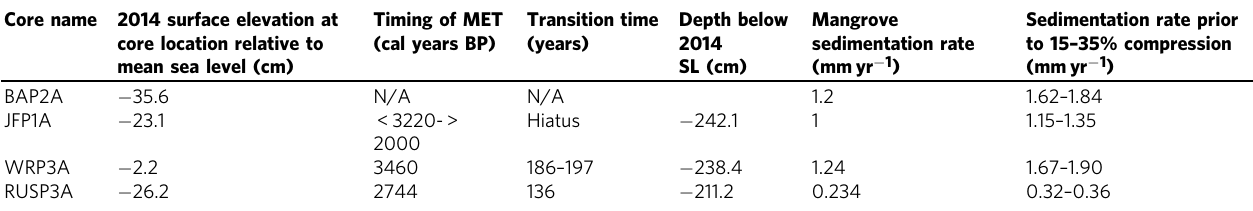
Surface elevations were measured using dGPS and measuring depth from bedrock on each island. Timing of inundation and sedimentation rates were identi fi ed using age models and centimeter-scale accretion between dated intervals, as described in supplemental